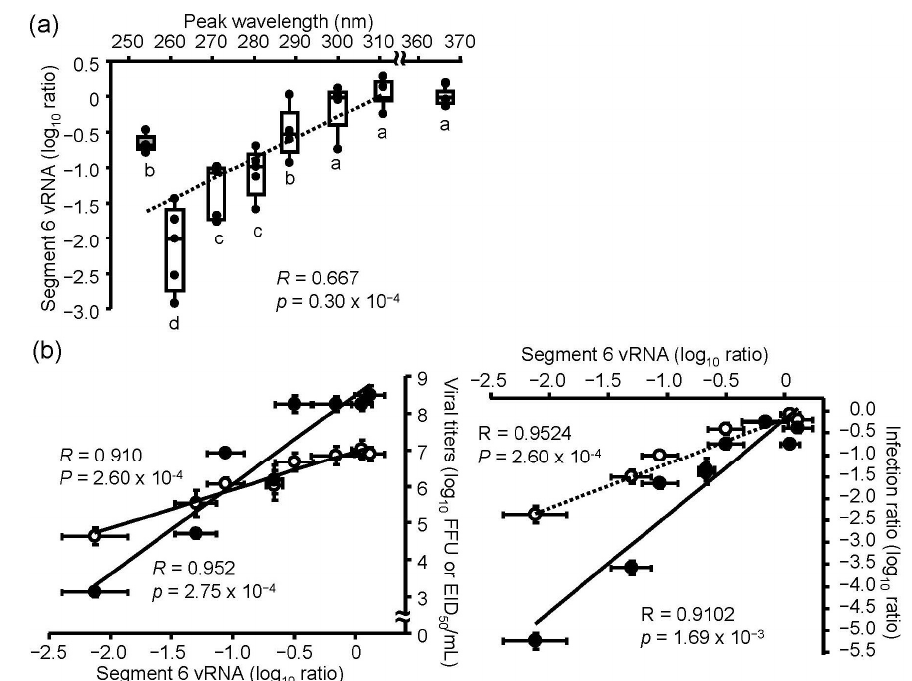
Figure 4. Effect of UV-LED irradiation on viral RNA. Viral suspensions of the H1N1 subtype (strain A/Puerto Rico/8/1934) were irradiated by UV-LEDs or an LP-UV lamp. Viral RNA damage was measured by vRNA (segment 6) strand-specific RT-qPCR, as described in the Materials and Methods section. ( a ) Damage of viral RNA by each UV irradiation. The dashed line shows the relationship between the peak wavelength and infection ratio. Different letters of the alphabet indicate a statistical difference ( p < 0.05) between each other ( n = 4–6, n = number of independent replicates). ( b ) The relationship between the inactivation effects and damage of viral RNA by each UV irradiation. Open circles and the dashed line indicate the data of the infection to MDCK cells. Filled circles and the solid line indicate the infection to embryonated chicken eggs. Viral inactivation effects of these irradiations were indicated by the difference of viral titers (left panels) and the log 10 focus-forming assay (FFU) ratio and embryo infection dose (EID 50 ) ratio (right panels), as described in the Materials and Methods section. Results are displayed as means ± SE.